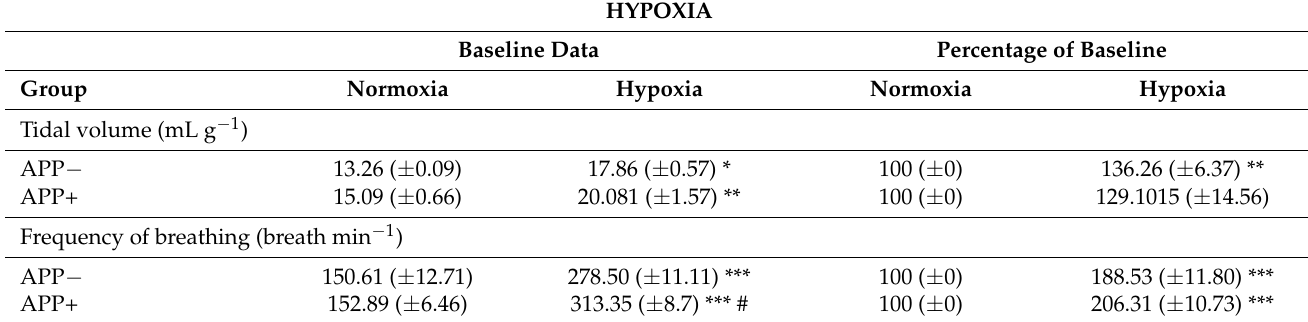
Table 1. Tidal volume (V T ) and frequency of breathing (F) baseline values during air breathing (normoxia), hypoxia, and hypercapnia in APP+ and APP − mice. In the two right columns, V T and F during the respiratory response to hypoxia and hypercapnia are expressed as a percentage of baseline values in